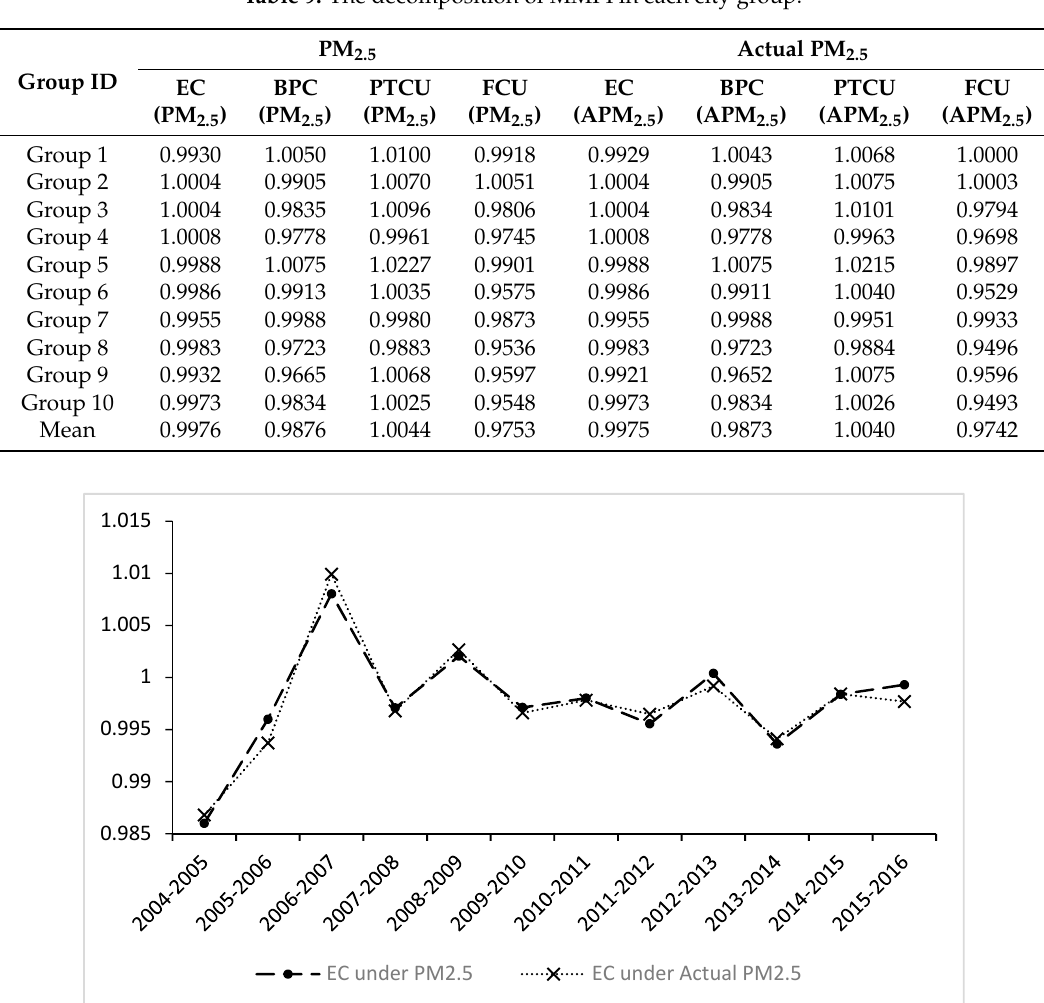
Table 9. The decomposition of MMPI in each city group.